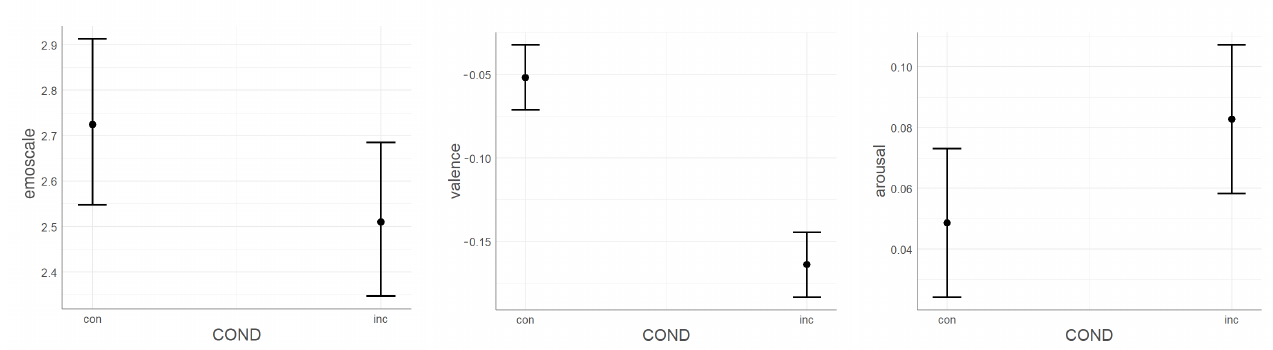
Figure 7. Mixed model of the influence of binary stimuli conditions on: the emoscale widget response ( left ), the emospace valence vector response ( center ), and the emospace arousal vector response ( right